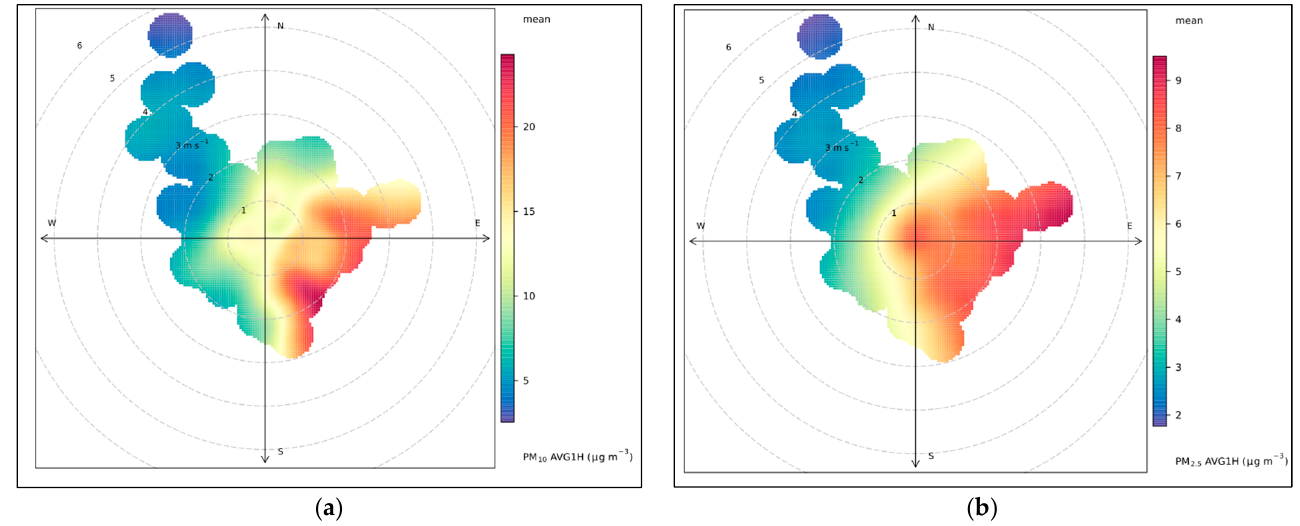
Figure 8. Average wind speed vs. PM 10 ( a ) and PM 2.5 ; ( b ) 24 h average over the experimental pe- riod 20 August–15 September 2022.